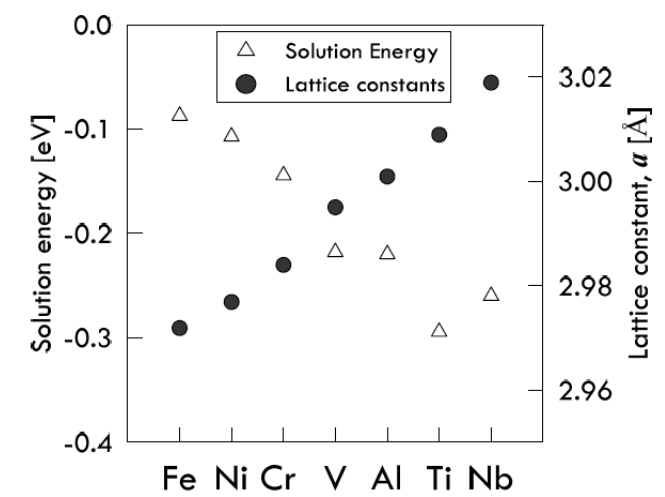
Figure 3. Solution energy of hydrogen in V 15 M alloys, compared with the lattice constants of each alloy. Adapted from Lu et al. [21].